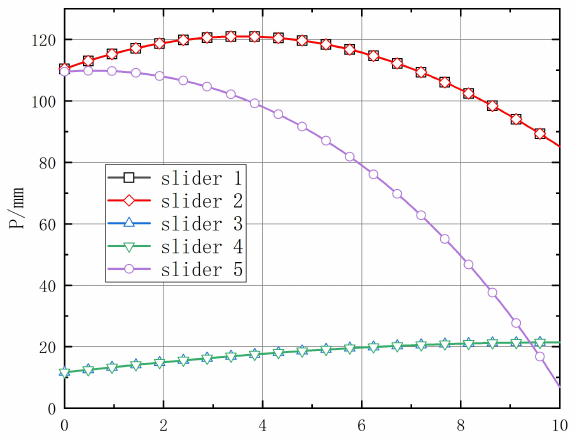
Figure 9. Position curves of